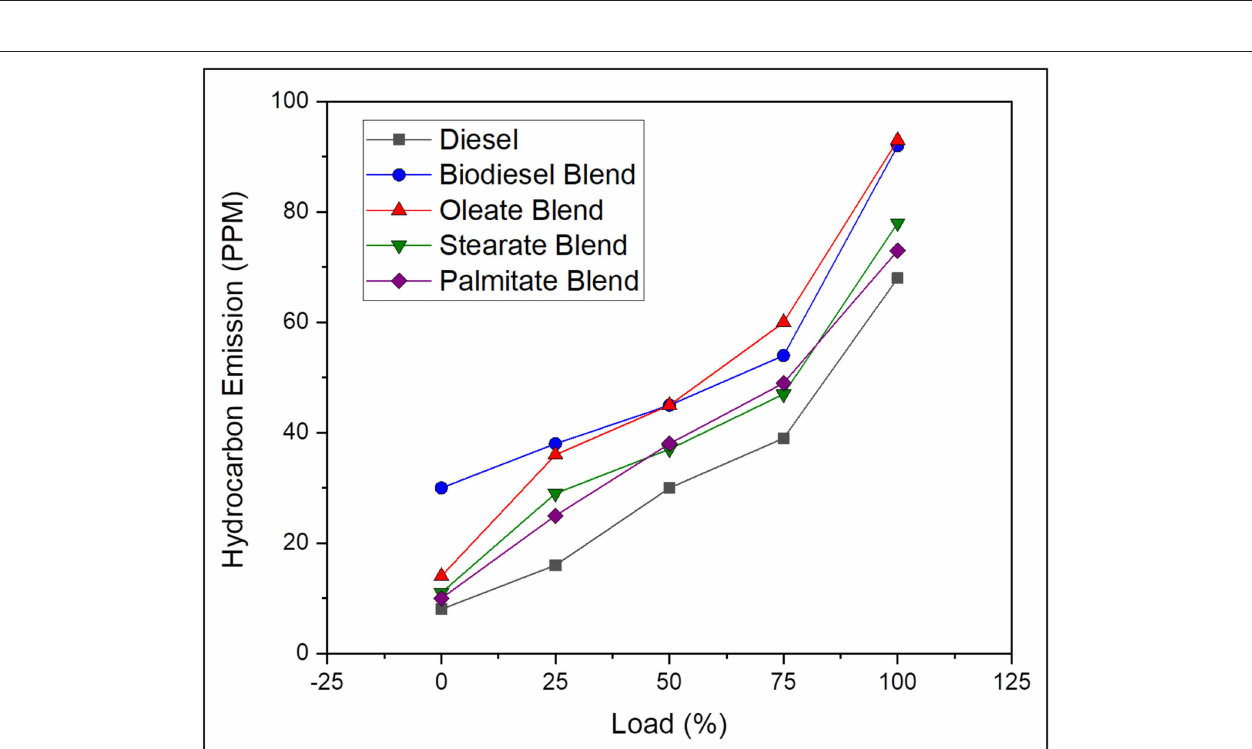
FIGURE 9 | Hydrocarbon emission of diesel and blend samples for varying load conditions.